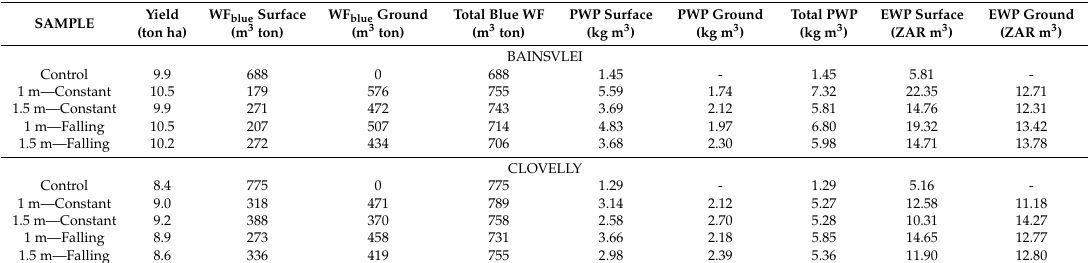
Table 4. Blue water footprint benchmarks for different groundwater levels at the Vaalharts and Orange-Riet